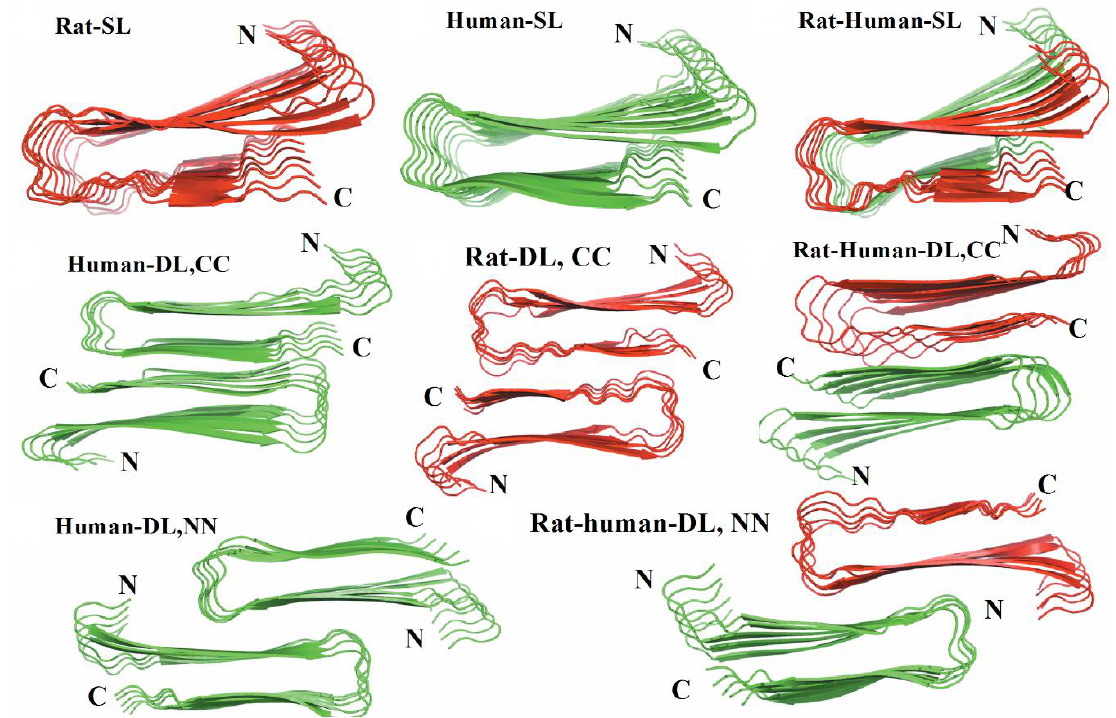
Figure 17. Single-layered (SL) and double-layered (DL) orientations of rIAPP and hIAPP homopentamers and heteropentamers, and the location of the water channel. These structures are arranged in different combinations of N-terminal and C-terminal order. Adapted from Berhanu and Hansmann [110]. Copyright 2014 Berhanu, Hansmann.